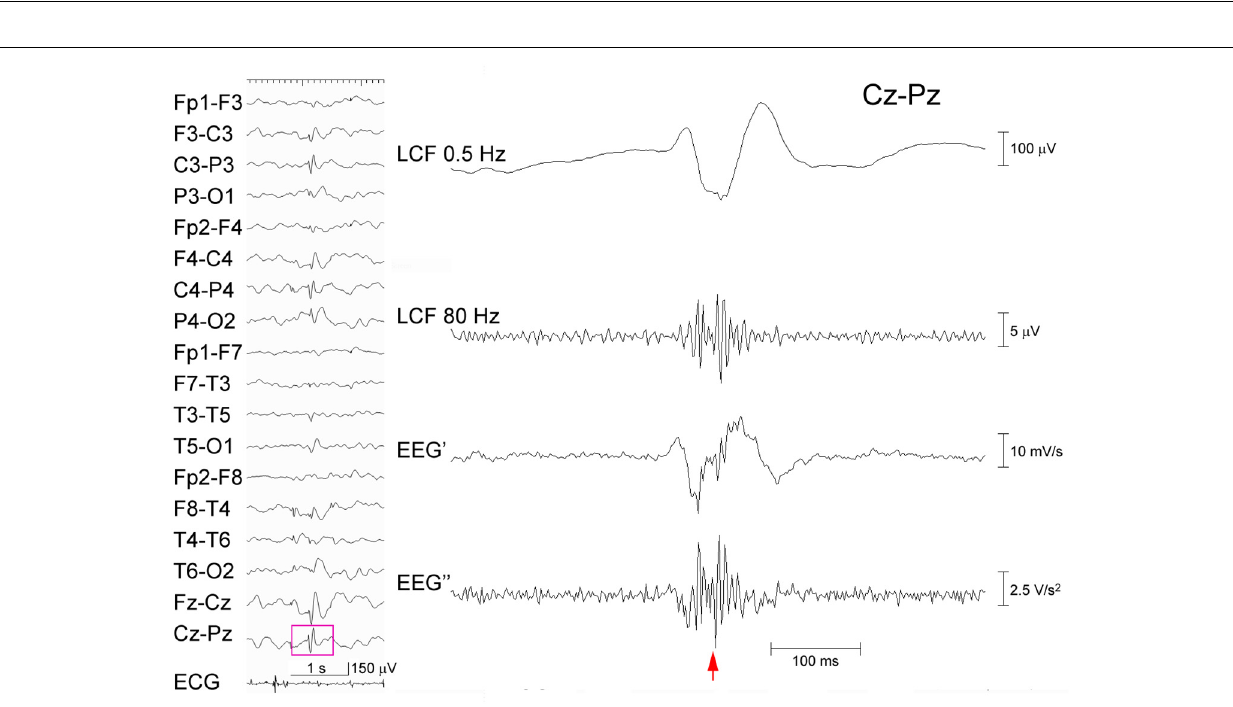
Frontiers in Human Neuroscience |